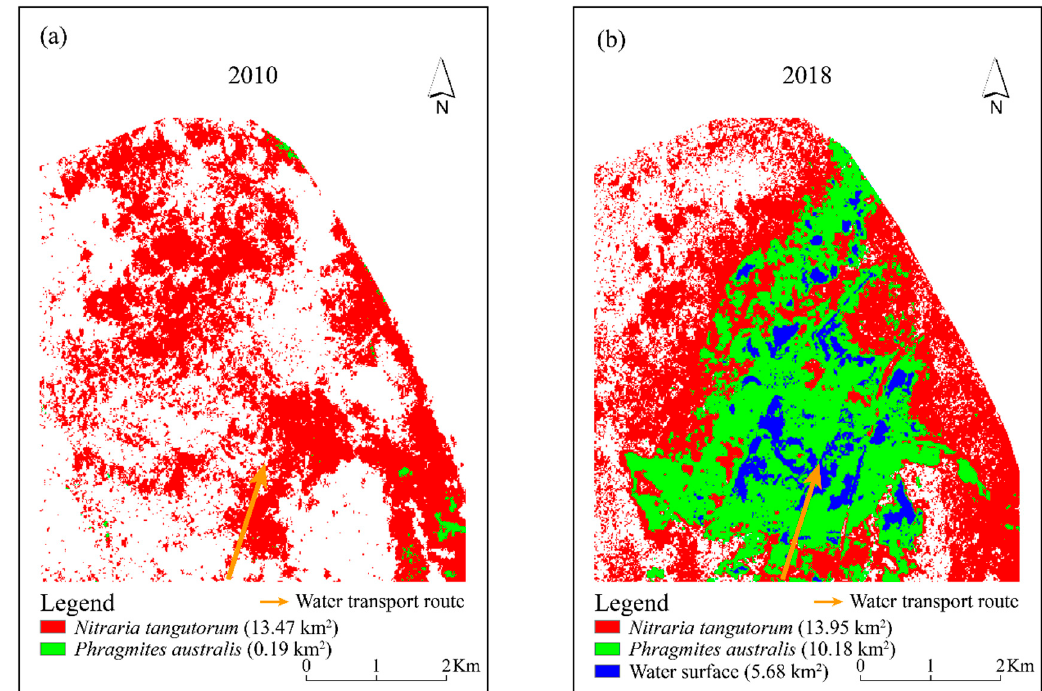
Figure 7. Panel ( a ): variation in N. tangutorum and P. australis distribution of Qingtu Lake in July 2010. Panel ( b ): variation in N. tangutorum , P. australis and water surface distribution of Qingtu Lake in July 2018.